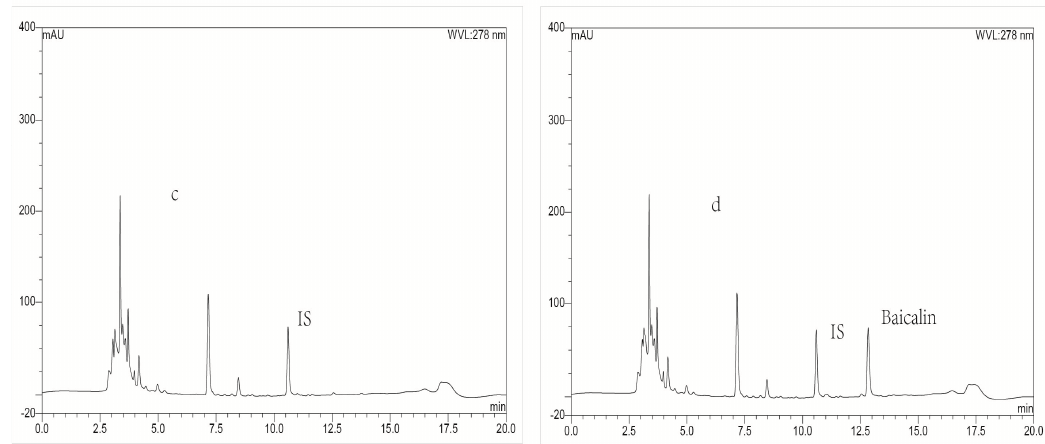
Figure 2. Representative LC-UV chromatograms obtained for blank plasma ( a ); blank plasma spiked with baicalin ( b ); blank plasma spiked with IS ( c ) and plasma biosample collected from a rabbit at 0.25 h after intravenous administration of baicalin-loaded liposomes at a dose of 10 mg/kg + IS ( d ).